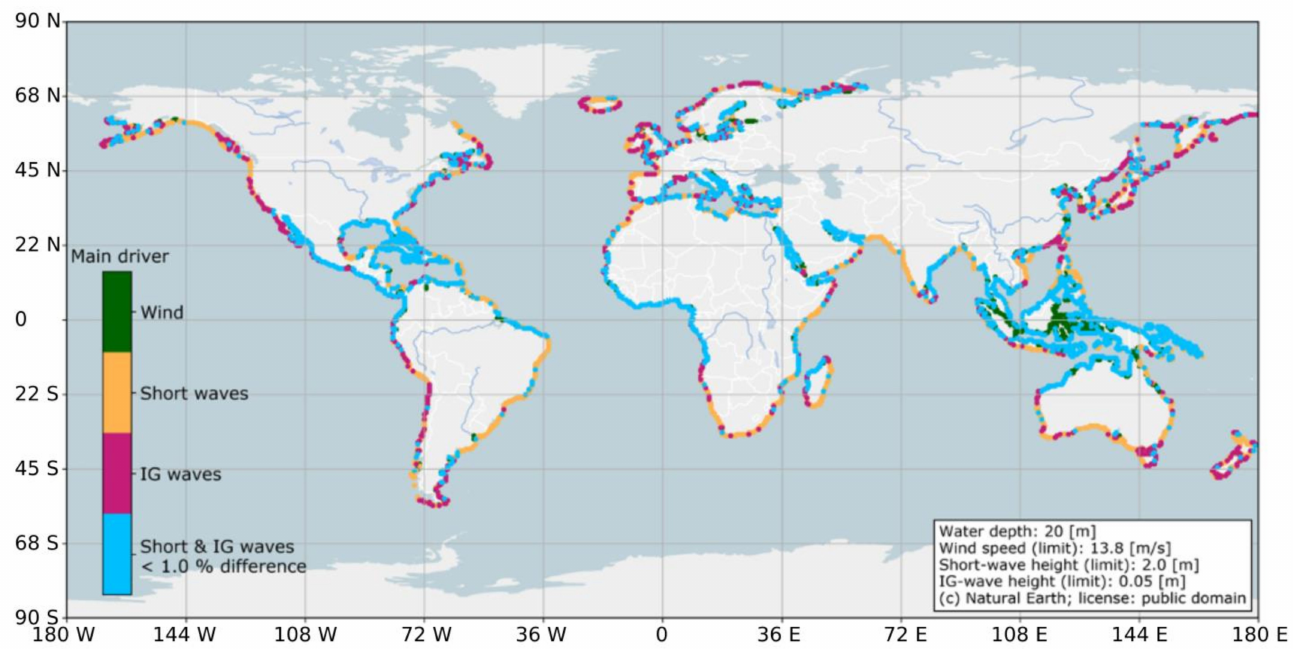
Figure 6. Geographical overview on the main drivers for port operability risks. Input/thresholds used in the method are given in the lower right corner.